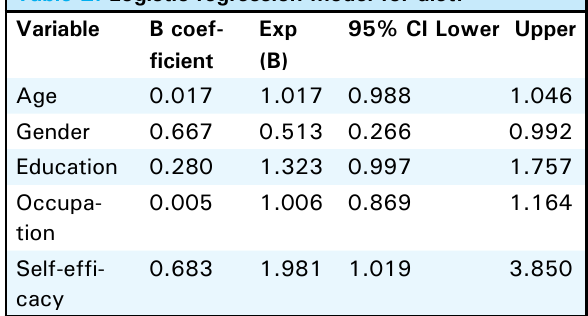
Table 2. Logistic regression model for diet.